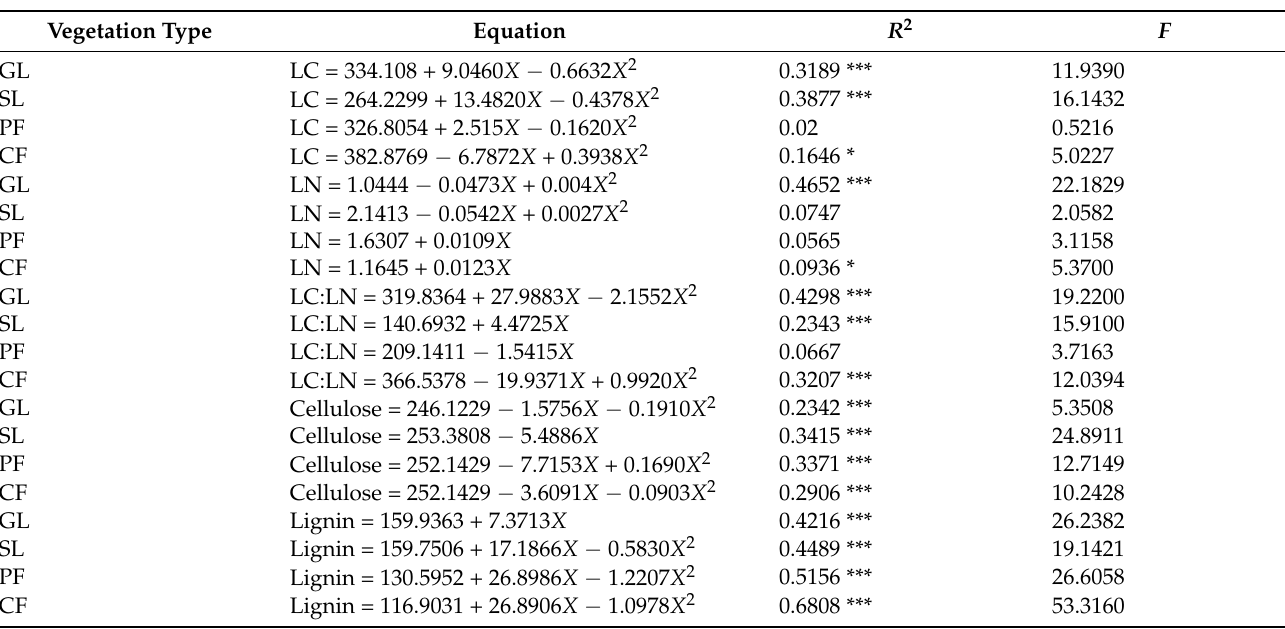
Table 1. Stepwise regression analysis of litter decomposition rate with litter properties.